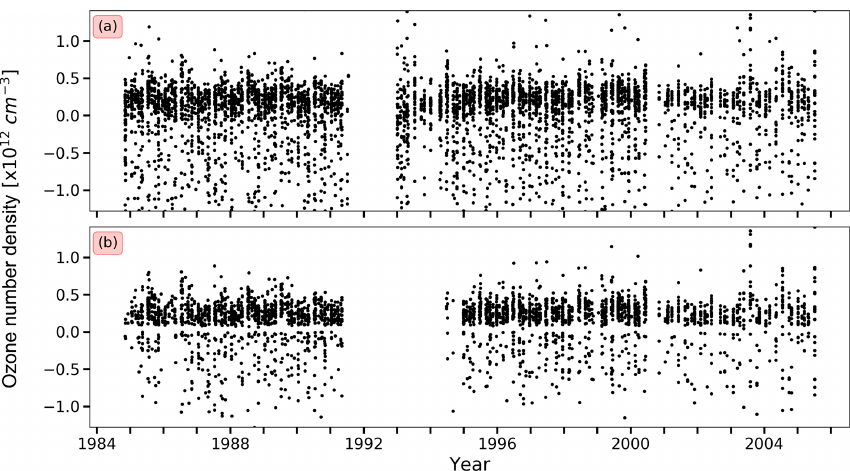
Figure 2. Ozone number density at 16km between 5 and 15 ◦ N from SAGE II: (a) all ozone data included in the SAGE II data in that latitude bin and the (b) remaining ozone data after current rule no. 3 has been applied. Note that the y axes have been fixed to the [ − 2 , 2] range to illustrate the removal of ozone data close to the zero